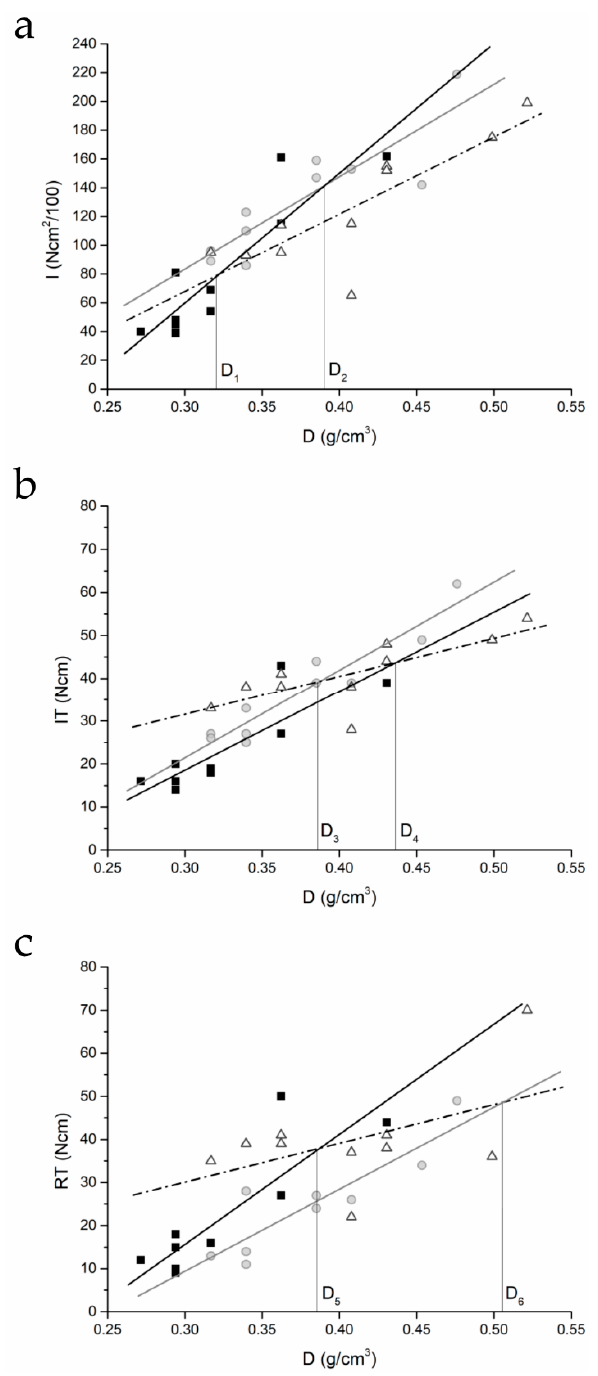
Figure 4. ( a ) Integral of the torque–depth curve (I)–density, ( b ) insertion torque (IT)–density, and ( c ) reverse torque (RT)–density plots for the three implants (square, cylindrical; circle, tapered; triangle, cylindrical-modified) placed after standard site preparation. The plots also show the density thresholds (D x ) where the lines cross.